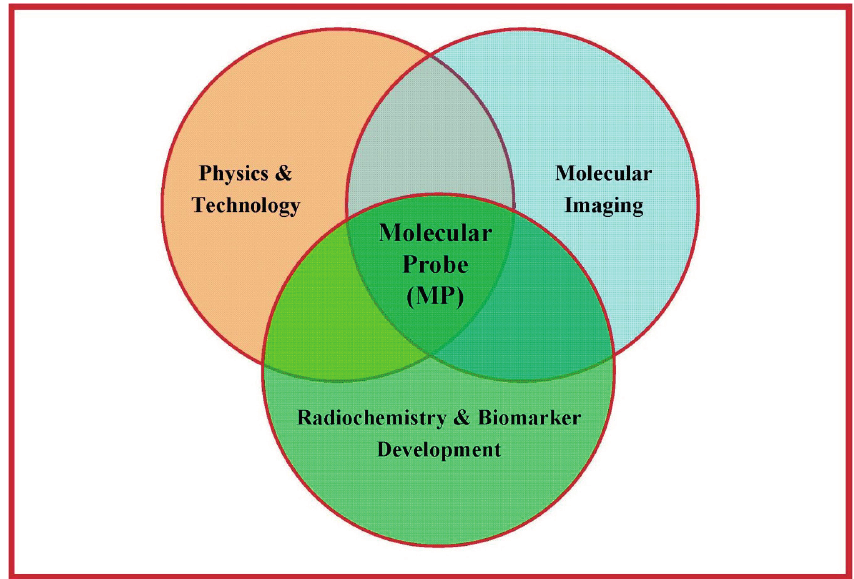
Figure 2. Necessary interplay of the three major disciplines involved in successful application of PET/MRI—the central role of the molecular probe is